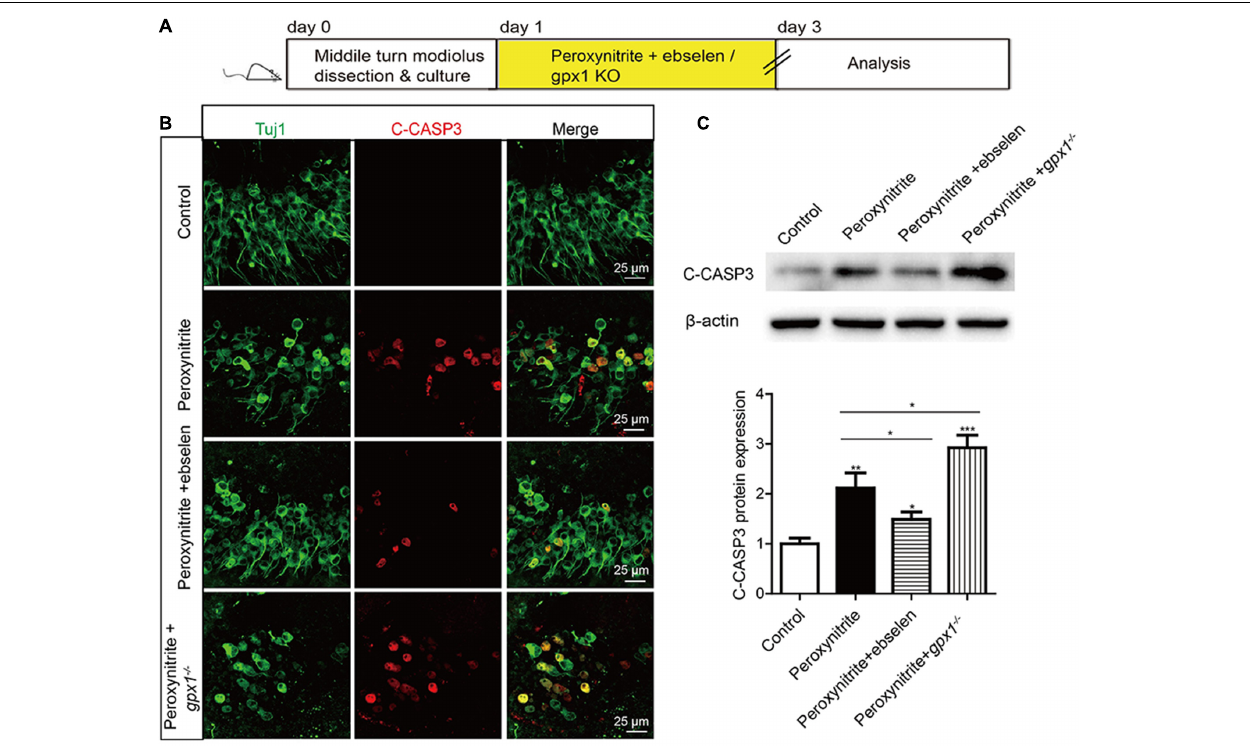
FIGURE 4 | Glutathione peroxidase inhibits the apoptosis of SGNs after peroxynitrite injury. (A) The cultured SGNs from P3 WT mice were incubated with 100 µ M peroxynitrite for 48 h with or without the pretreatment of 30 µ M ebselen for 1 h, or the SGNs from gpx1 − / − mice were cultured and exposed to 100 µ M peroxynitrite for 48 h. (B) Immunostaining results showed that distinct C-CASP3-positive SGNs were observed in the peroxynitrite group, but not in the control group. The number of C-CASP3-positive SGNs was downregulated in the presence of ebselen, while it was further increased in gpx1 − / − mice compared with the peroxynitrite-only group. Scale bar = 25 µ m. (C) The western blot analysis of C-CASP3 protein verified that the expression level of C-CASP3 was significantly reduced in the peroxynitrite + ebselen group, while it was significantly increased in the peroxynitrite + gpx1 − / − group compared with the peroxynitrite-only group. * p < 0.05, ** p < 0.01, and *** p < 0.001, n = 3 for each